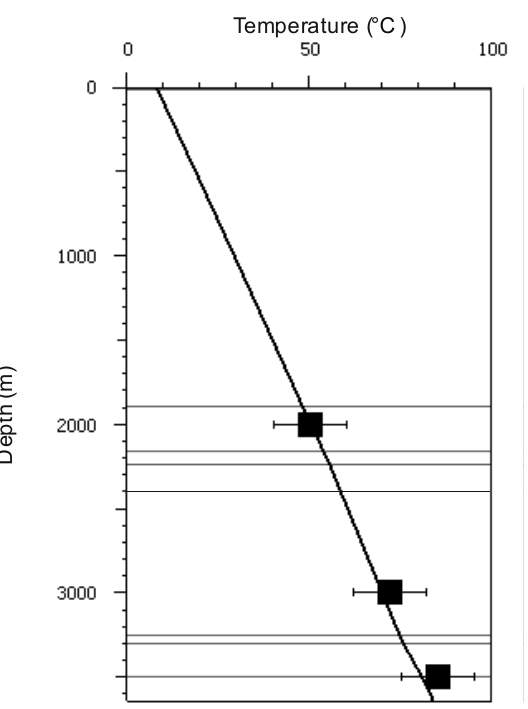
Figure 4. Calculated temperature curve using PetroMod software vs. measured data from [34].